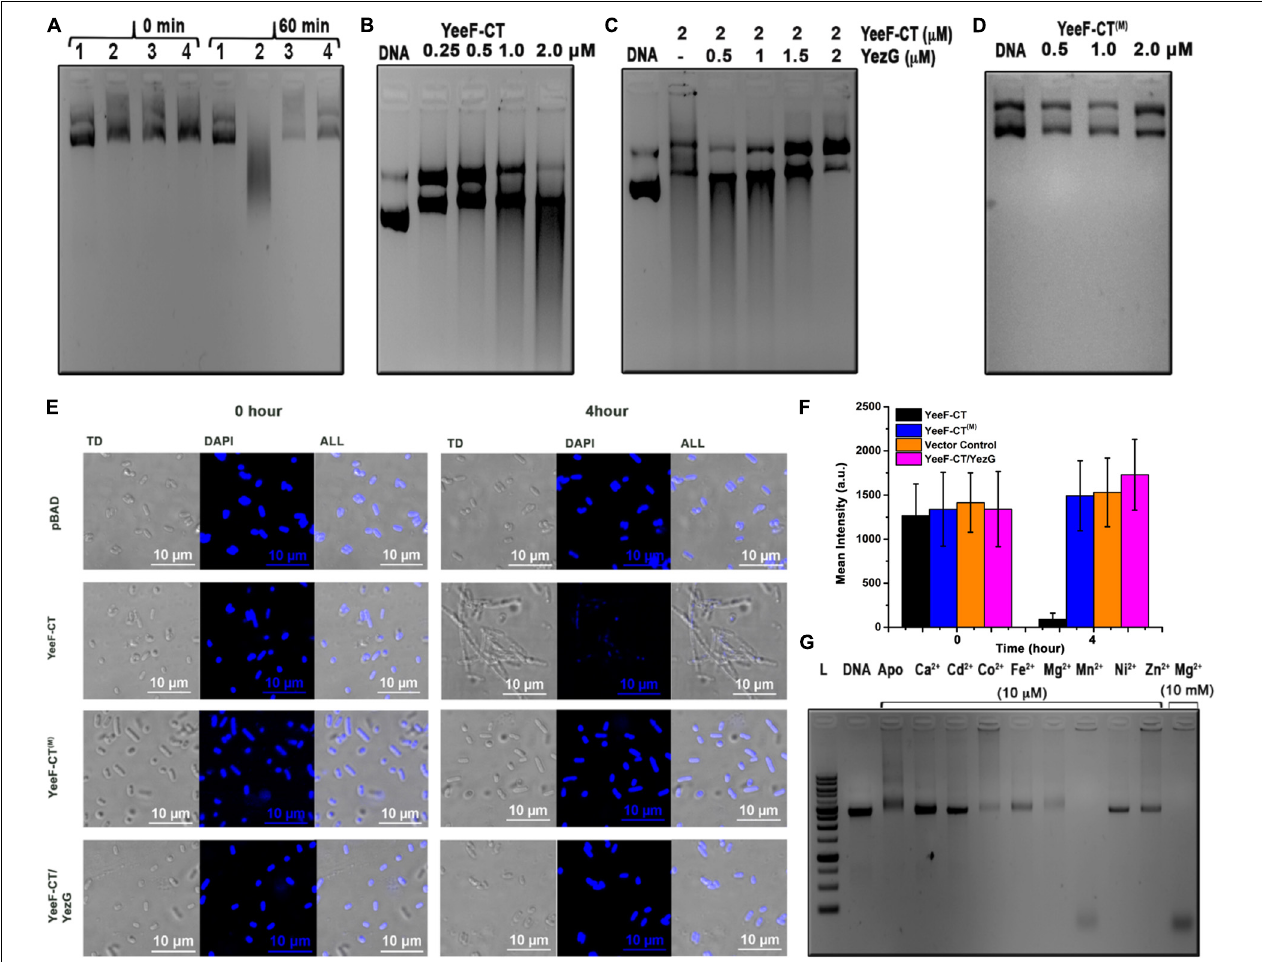
FIGURE 3 | In vitro and in vivo characterization of the molecular target of YeeF-CT. (A) Electrophoresis of genomic DNA isolated from the cells carrying plasmid only, expressing YeeF-CT, YeeF-CT ( M ) , and YeeF-CT/YezG at 0 and 60 min post-induction. In panel A ; 1, 2, 3, 4 represents cells carrying plasmid only, YeeF-CT expressing cells, YeeF-CT ( M ) expressing cells, YeeF-CT/YezG expressing cells, respectively. (B) The agarose gel electrophoresis showing the degradation of plasmid DNA with different concentrations of purified YeeF-CT. (C) The agarose gel electrophoresis showing the protective role of YezG when plasmid DNA is incubated with a fixed concentration of YeeF-CT and increasing concentration of YezG. (D) Incubation of YeeF-CT ( M ) with plasmid DNA showing loss of DNase activity. (E) The confocal microscopic images of DAPI stained E. coli cells expressing YeeF-CT, YeeF-CT ( M ) and YeeF-CT/YezG showing damage to the DNA 4-hour post-induction of YeeF-CT with 0.1% L-Arabinose. (F) The histograms represent mean fluorescence intensity at 0 and 4 h post-induction of YeeF-CT, YeeF-CT ( M ) , YeeF-CT and YezG and negative control. (G) The agarose gel electrophoresis of plasmid DNA incubated with a fixed concentration of YeeF-CT and a fixed concentration of different metal